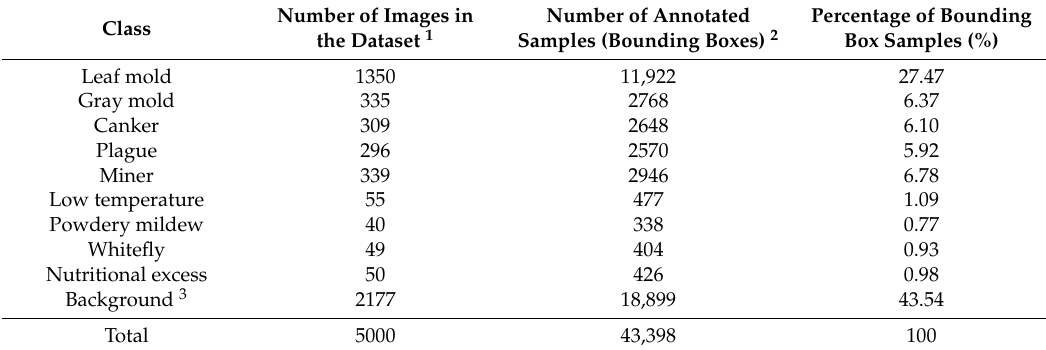
Table 3. List of Categories included in Our Tomato Diseases and Pests Dataset and their Annotated